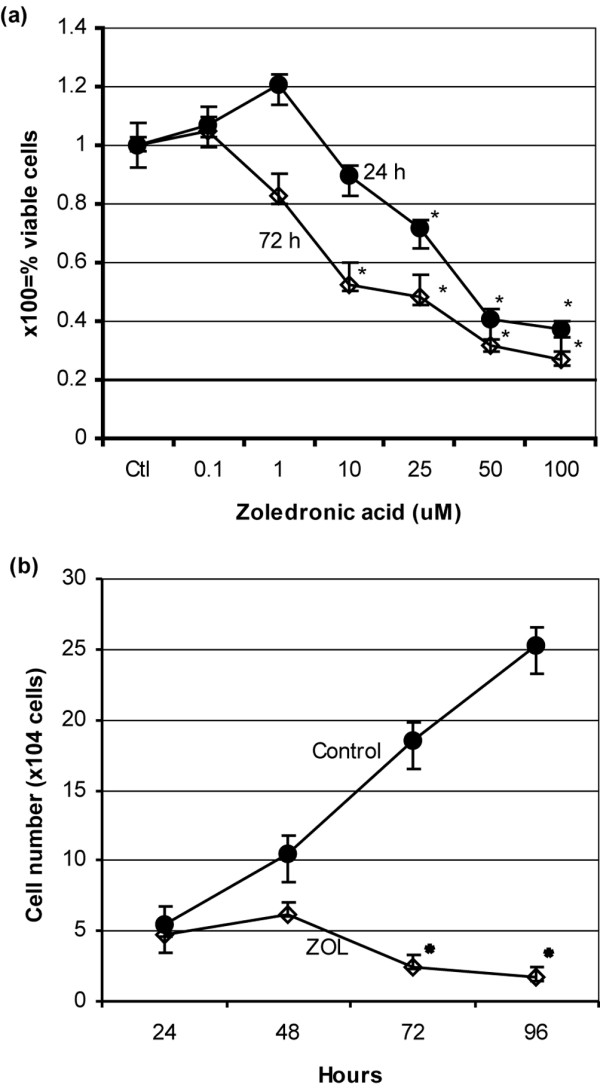
Effect of zoledronic acid treatment on MCF-7 cell viability. (a) MCF-7 cells treated with increasing concentrations of zoledronic acid (0.1–100 μM) for 24 and 72 hours to determine a 50% growth inhibition (IC50) value. (b) MCF-7 cells treated with 20 μM zoledronic acid for increasing time of incubation to determine the time dependence of zoledronic acid (ZOL) toxicity. Results are expressed as the percentage of control or absolute cell numbers. *Statistically significant values compared with control. Ctl, control.